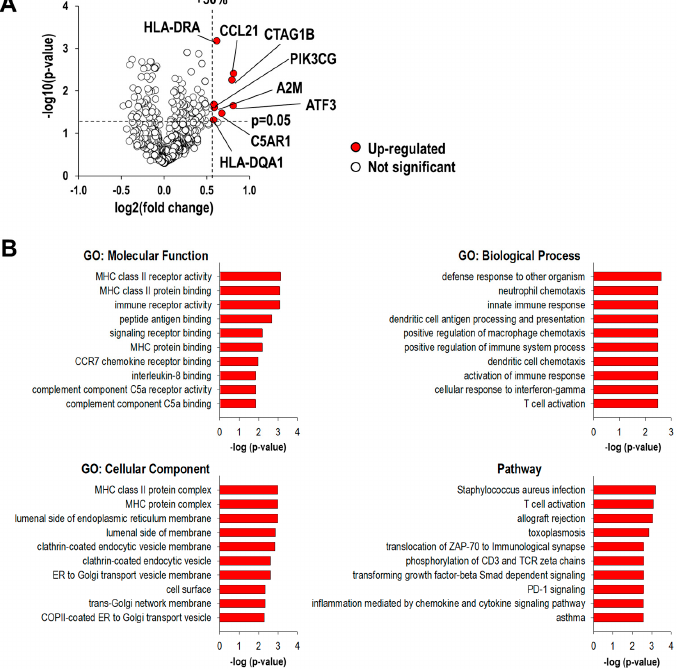
Figure 3. Transcriptomic analyses of H358 tumors using nCounter PanCancer Human IO 360 assay. ( A ) Volcano plot showing differential expression of genes in tumors treated with scL-RB94 versus the baseline of untreated tumors. The volcano plot is presented as fold change in gene expression [log 2 (fold change)] against statistical significance of change [ − log 10 ( p -value)]. ( B ) ToppGene Suite analysis of differentially expressed genes. Groups reflect main categories of gene ontology (GO) terms: molecular function, biological process, cellular component, and canonical pathway. Vertical and horizontal axes represent each category term and − log 10 (FDR adjusted p -value) of the corresponding term, respectively.